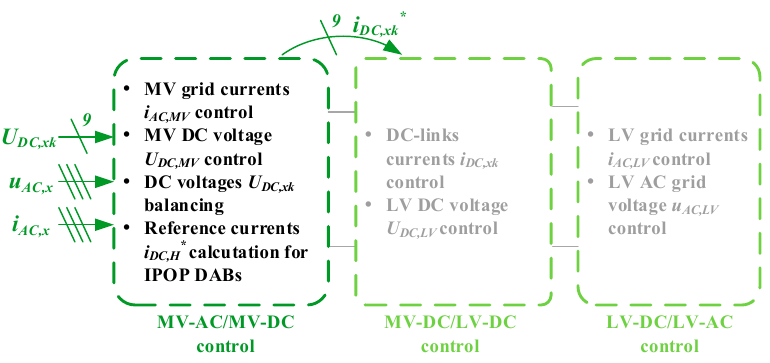
Figure 7. Main functions of each stage of SST’s control.